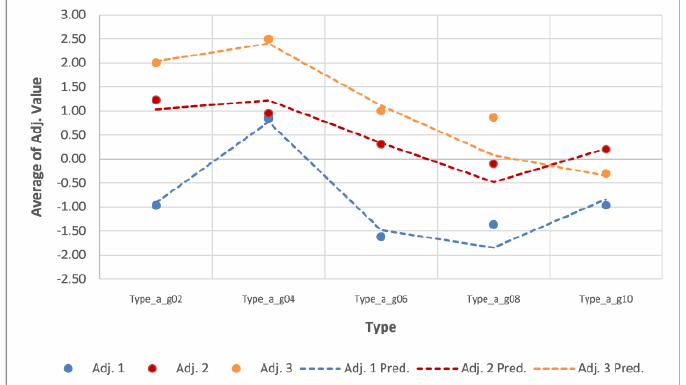
Figure 7. Prediction performance for vertical color gradients. Adj1 (elegant–artless); Adj2 (rare–